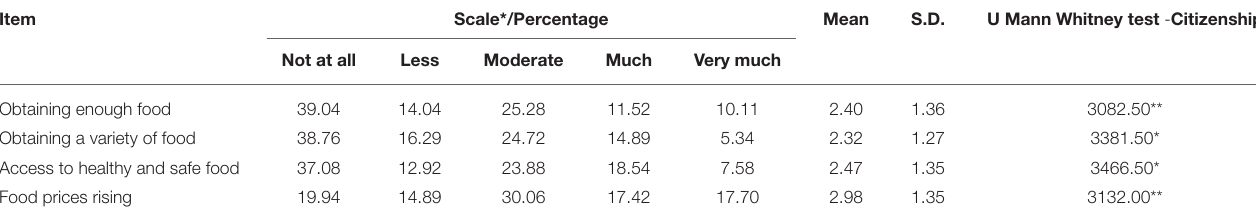
TABLE 6 | Stocking up and food-related concerns during the COVID-19 pandemic and comparison between groups of citizenships. Item